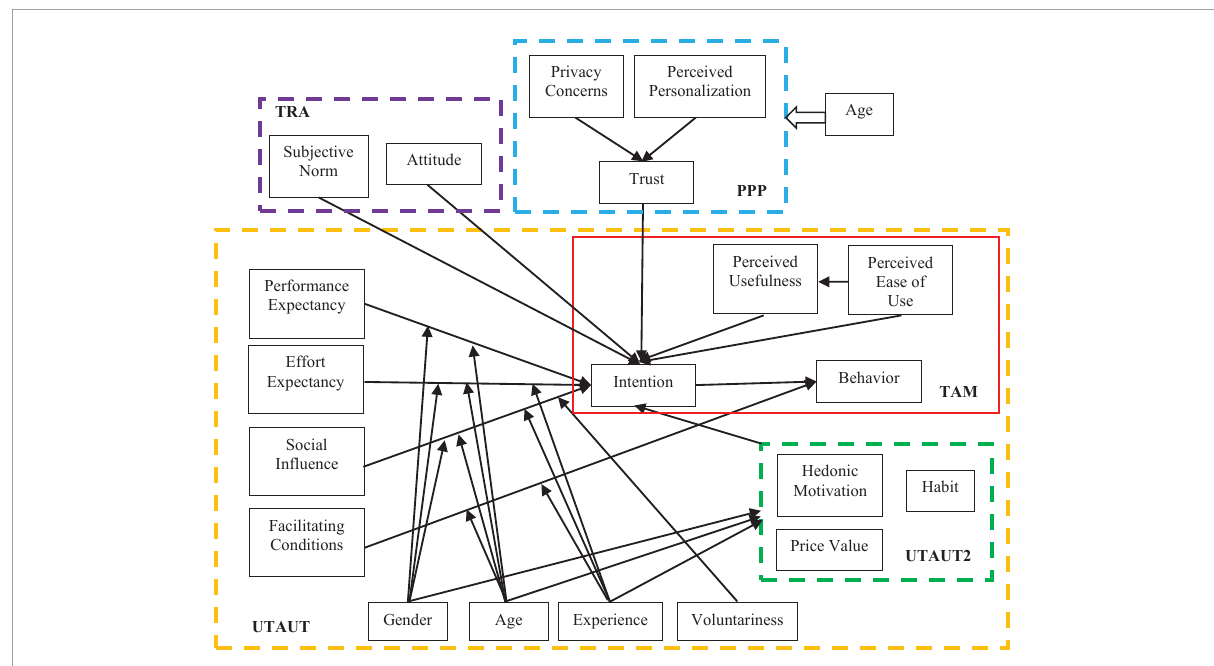
FIGURE1 Unified theory of acceptance and use of technology (UTAUT) and its extended